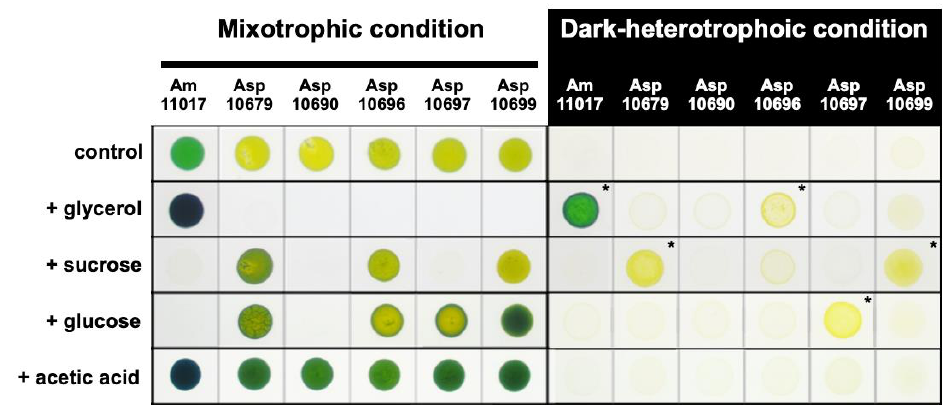
Figure 2. Mixotrophic and Heterotrophic growth of Acaryochloris species. Six Acaryochloris species ( A. marina MBIC11017; Am11017, A . sp MBIC10679; Asp10679, A . sp MBIC10690; Asp10690, A . sp MBIC10696; Asp10696, A . sp MBIC10697; Asp10697, A . sp MBIC10699; Asp10699) grew with several carbon sources under light or dark condition for 20 days. Control means without carbon sources. Asterisks indicate significant growth under the dark-heterotrophic conditions.